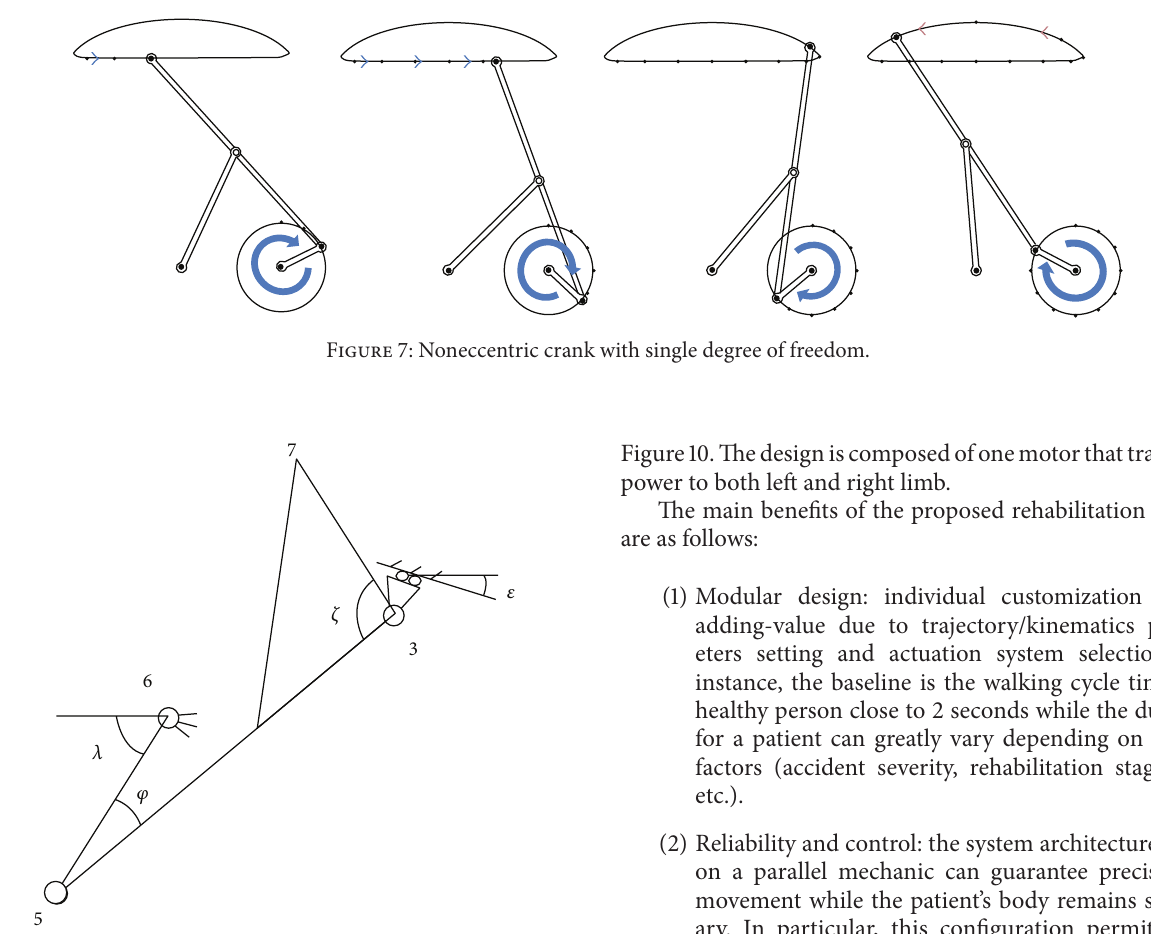
Figure 8: An overview of the articulated mechanism.